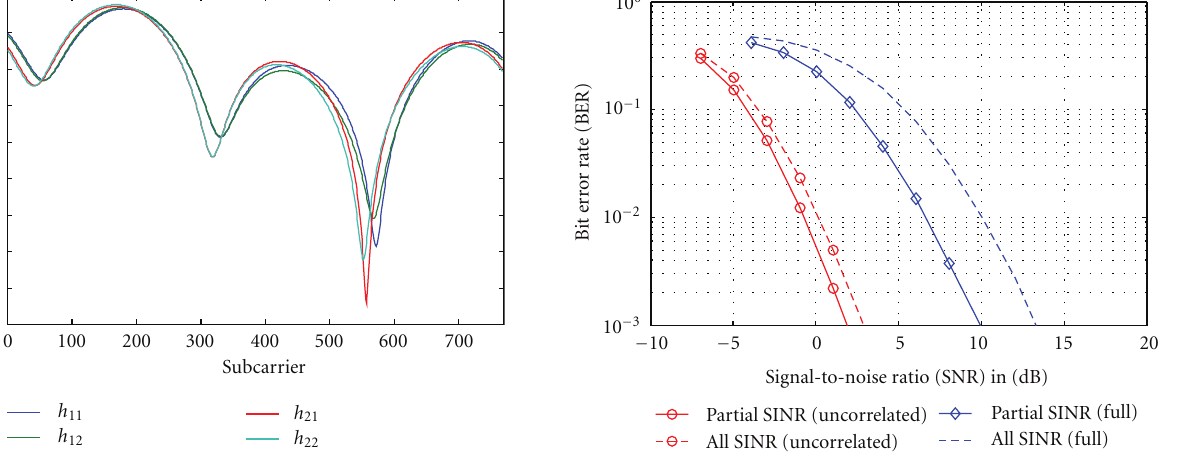
Figure 6: BER performance between two variants of DSA-SINR in di ff erent correlation